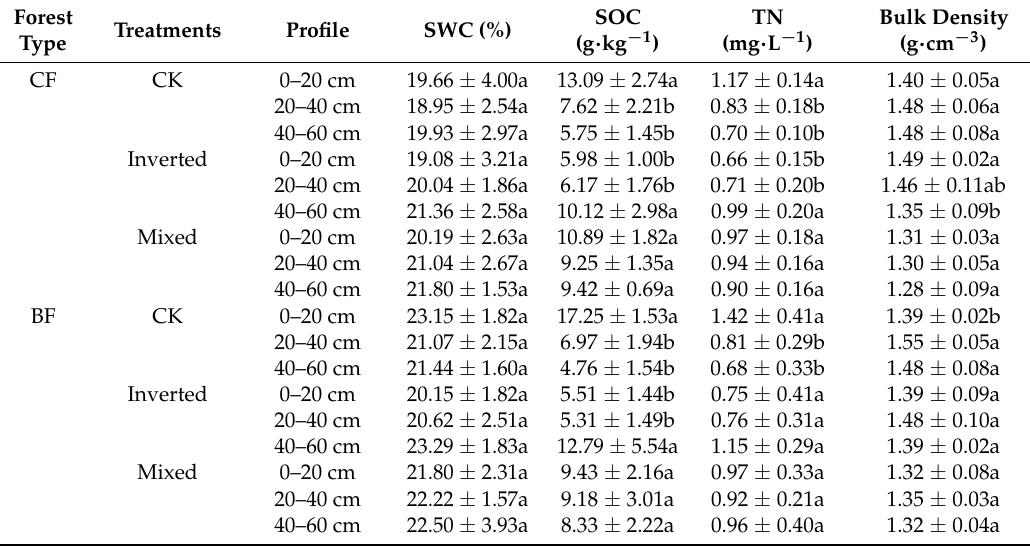
Table 1. Soil physical and chemical properties by depth and soil columns manipulation, including soil water content (SWC), total organic carbon (TOC), total nitrogen (TN) and bulk density. Error bars represent the standard errors of the mean ( n = 4). Different letters represent significant differences (LSD test, p < 0.05).